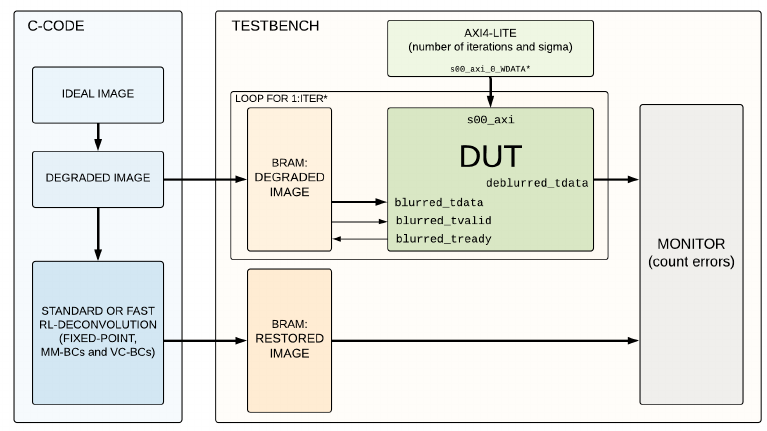
Figure 17. Verification of the RL deconvolution Design Under Test